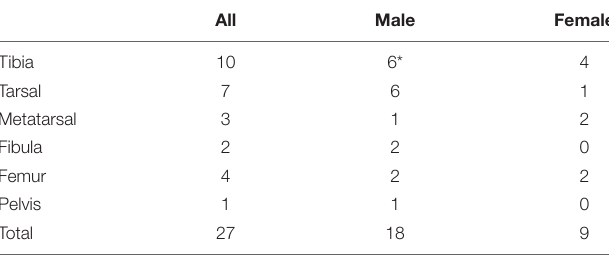
TABLE 2 | Breakdown of frequency and location of the 27 bone stress injuries that were diagnosed in 21 officer candidates during training.